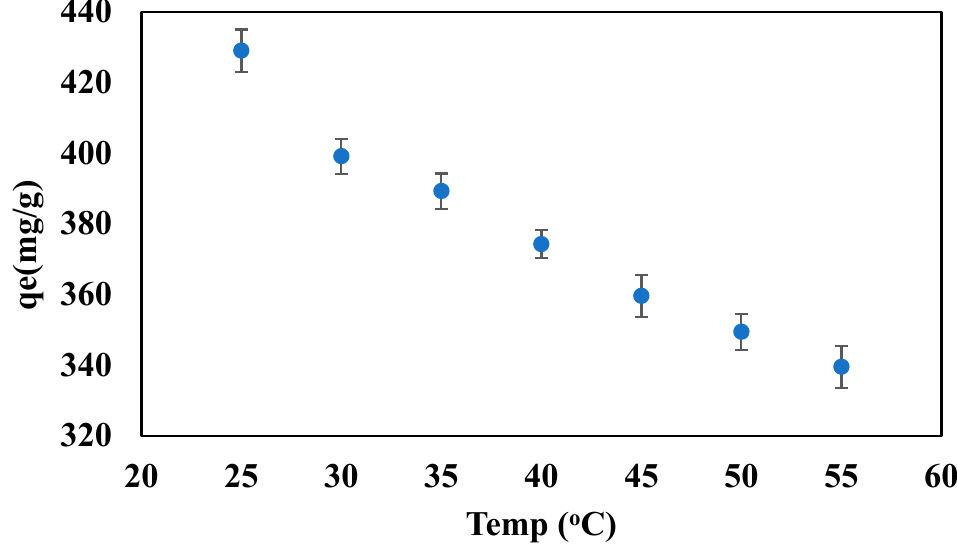
Figure 7. Effect of the temperature on the adsorption capacity of the beads at 600 ppm initial oil concentration, pH 10, 10 mg beads dosage, and 70 min contact time.